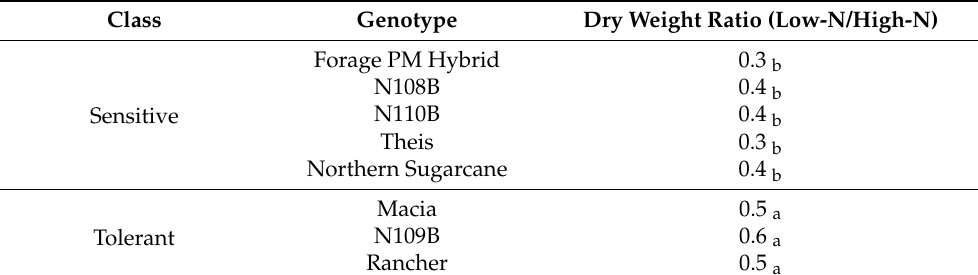
Table 1. Plant genotypes used in this study. Shoot dry weight ratio of each genotype measured in 2015. The division of lines sensitive and tolerant to nitrogen (N) stress is shown. Different letters indicate significant differences according to t -test ( p <